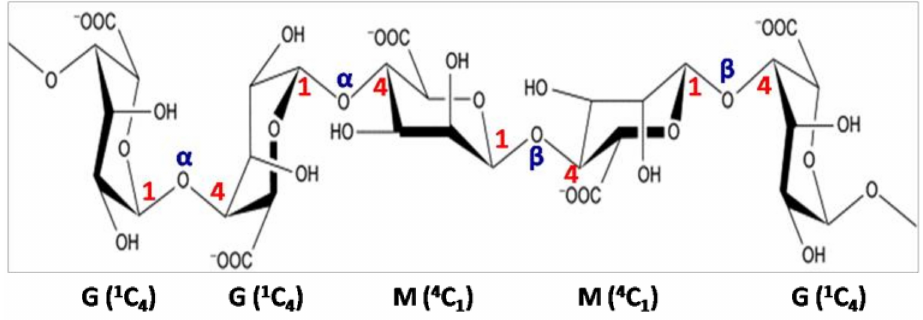
Figure 7. Structure of alginates. G: guluronate or l -Gul p A; M: mannuronate or d -Man p